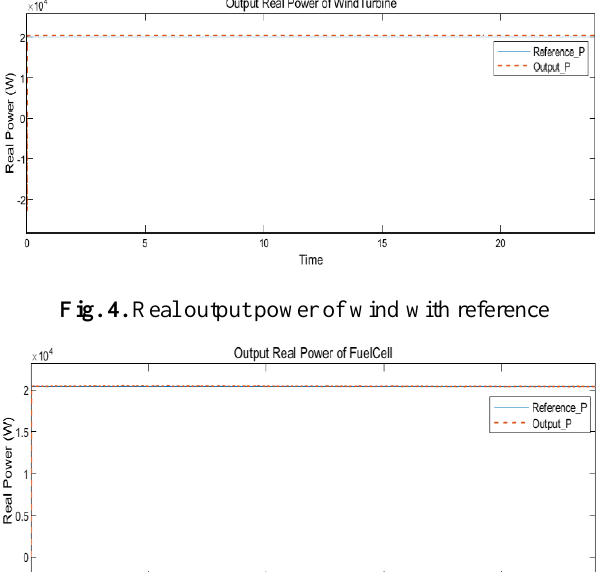
Fig.8. Frequency of load